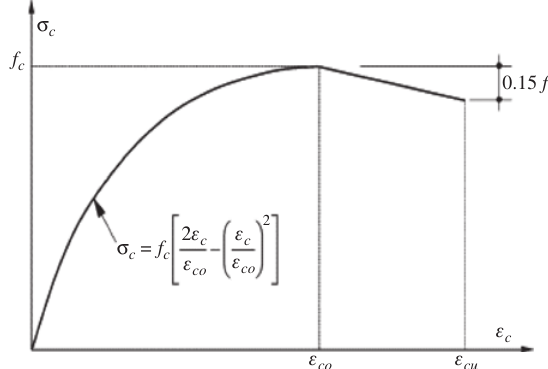
Figure 4: Stress-strain curve for ordinary concrete proposed by [19].